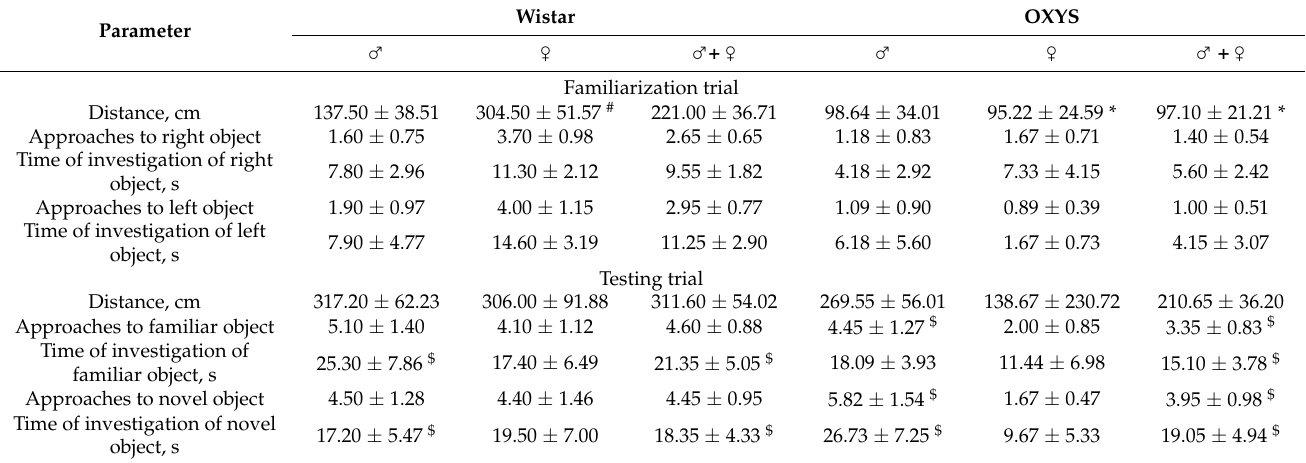
Table 7. Assessment of the learning ability in Wistar and OXYS rats in the OLR test (PND17). Parameter